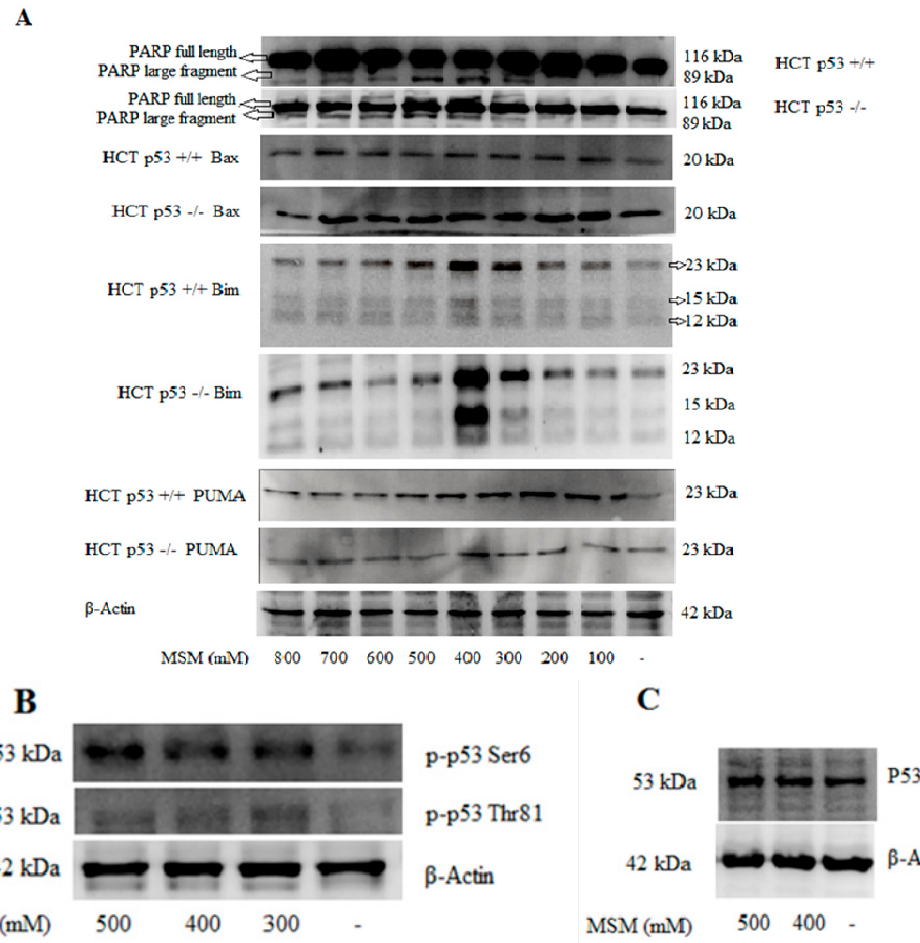
upregulated modulator of apoptosis (PUMA) proteins in HCT-116 p53 +/+ and p53 − / − colon cancer cells; ( B ) representative blot image showing the effects of MSM on p-p53 (Thr81) and p-p53 (Ser6) proteins in HCT-116 p53 +/+ colon cancer cells. Representative blot image showing the effect